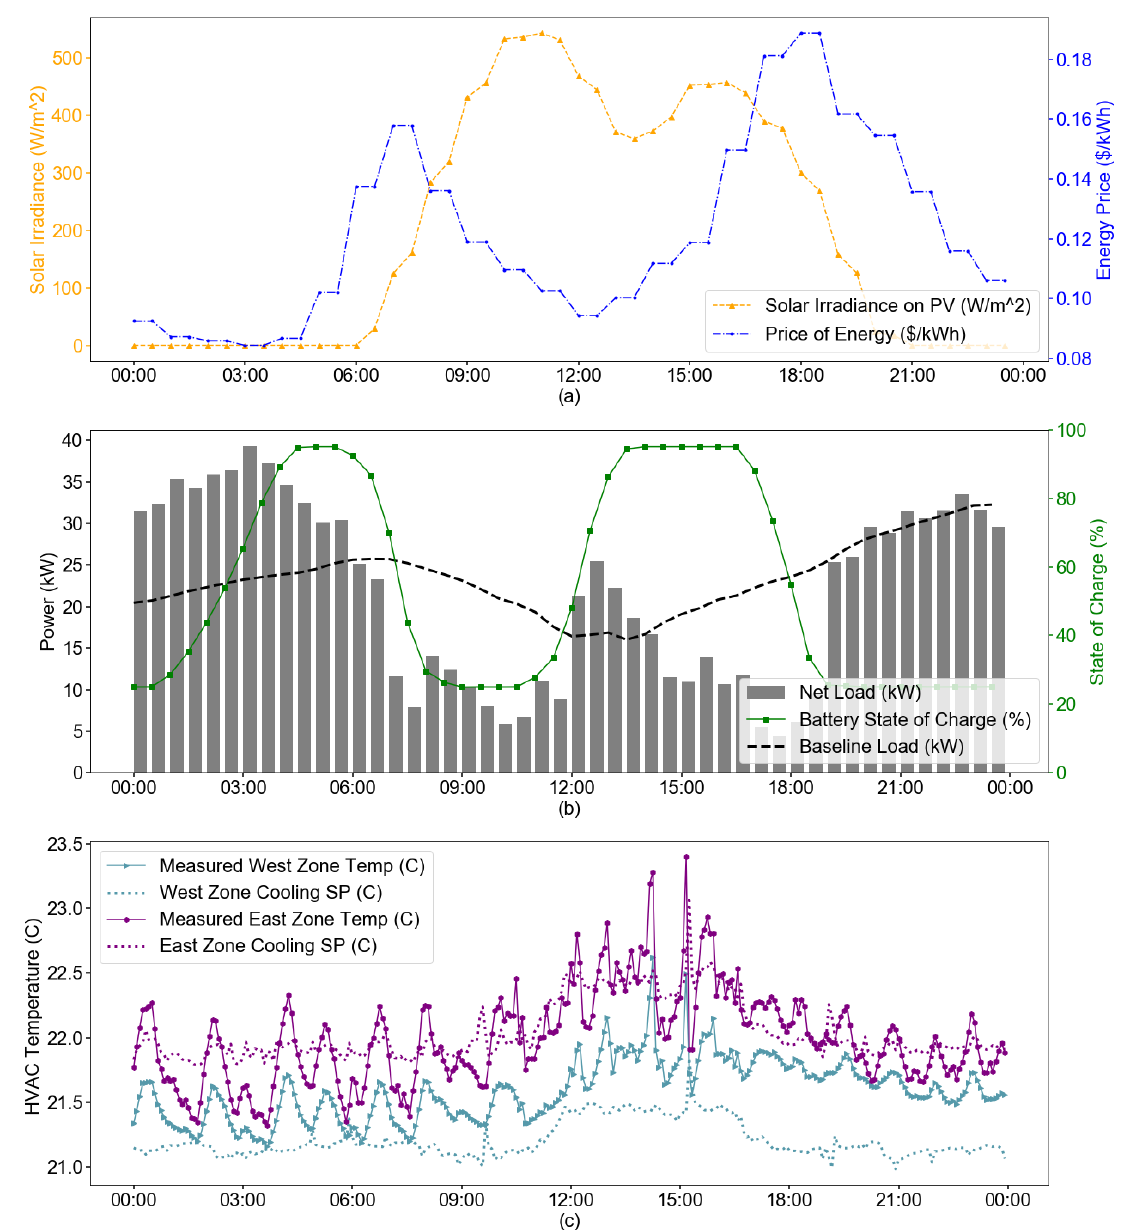
Figure 8. ( a ) SPO’s response to hourly dynamic prices and varying solar irradiance. ( b ) Through battery discharge and reduction in building load, where the net load is minimum during high price times and the battery charges during the low price times anticipating the high price period. ( c ) SPO changes the thermostat setpoints to vary the zone temperature. Preferred temperatures: 20.56 ◦ C (69 ◦ F) for the West Zone and 21.67 ◦ C (71 ◦ F) for the East